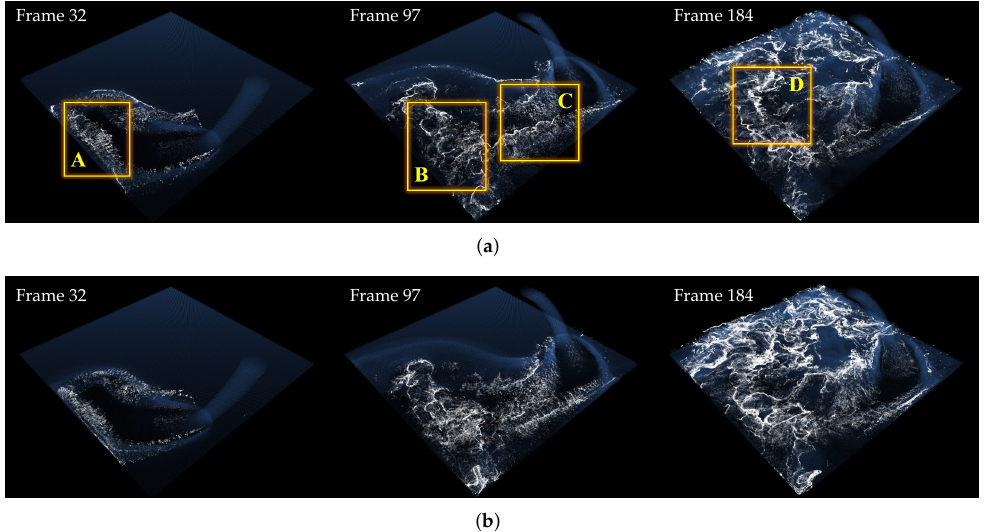
Figure 10. Comparison of the rotating-emitter scene in water simulation. The related video has been submitted as Supplementary Material. ( a ) Our method. ( b ) Kim and Lee [26].